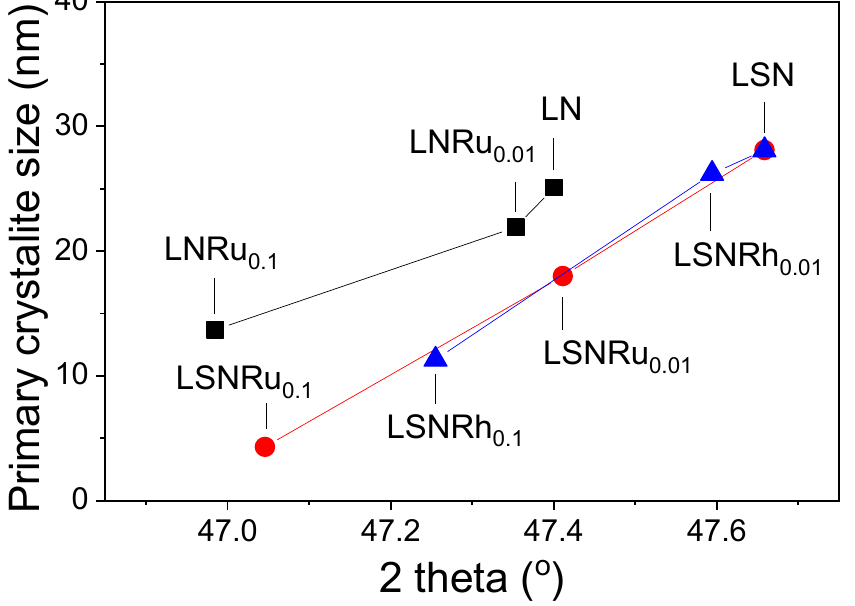
Figure 2. Dependence of the mean primary size of the perovskite crystallites, and of the angle corresponding to the (200) reflection on the type (Ru or Rh) and content ( x = 0, 0.01, 0.1) of the B-site cation in LNRu x , LSNRu x , and LSNRh x samples (data extracted from the XRD patterns shown in Figure